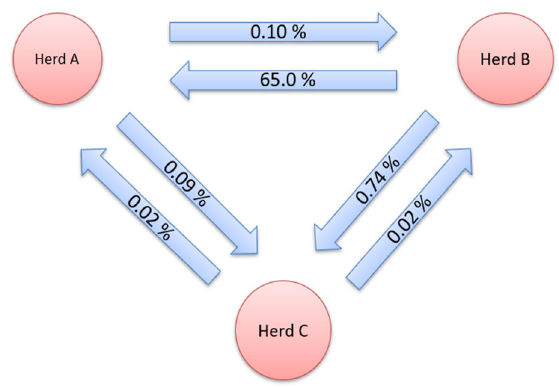
Figure 1. Gene flow between herds for purebred data.